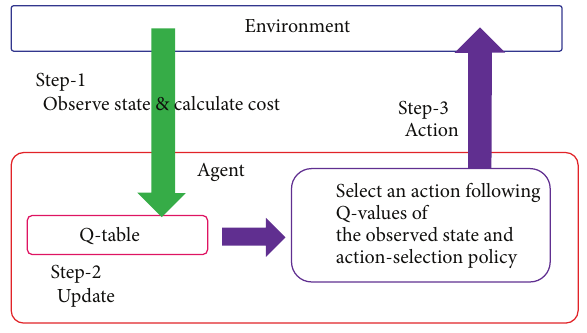
Figure 7: Q-learning flow [8].